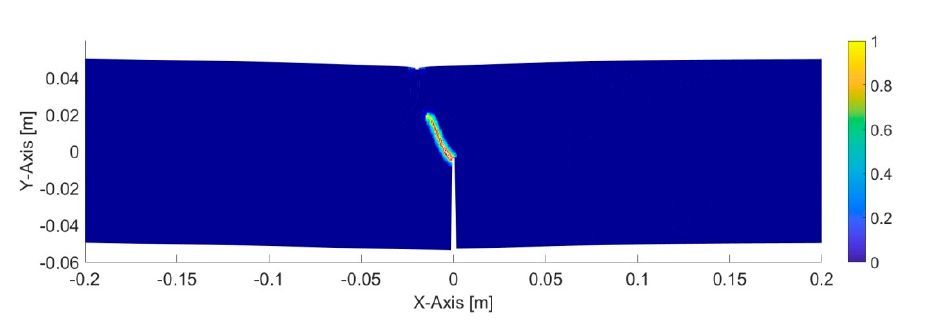
Figure 1. Experimental setup.